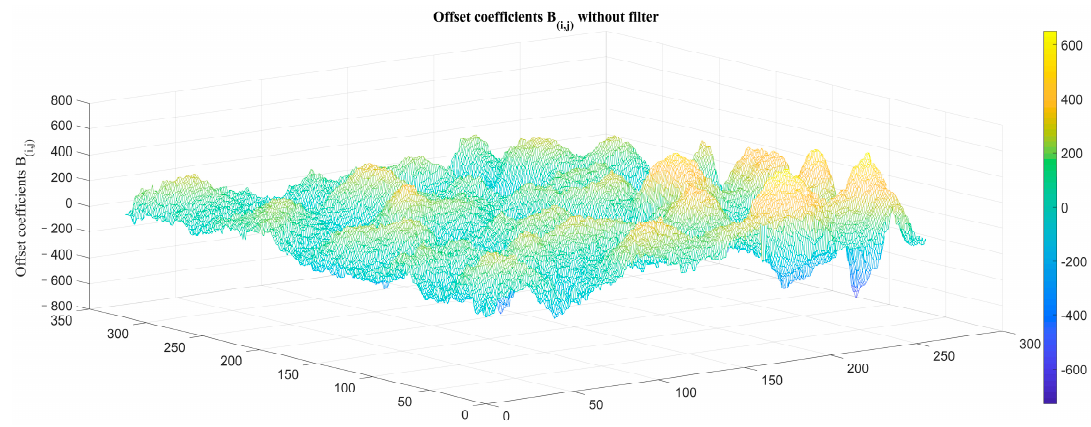
Figure 10. TPC offset coefficients B i,j without atmospheric transmittance filter.